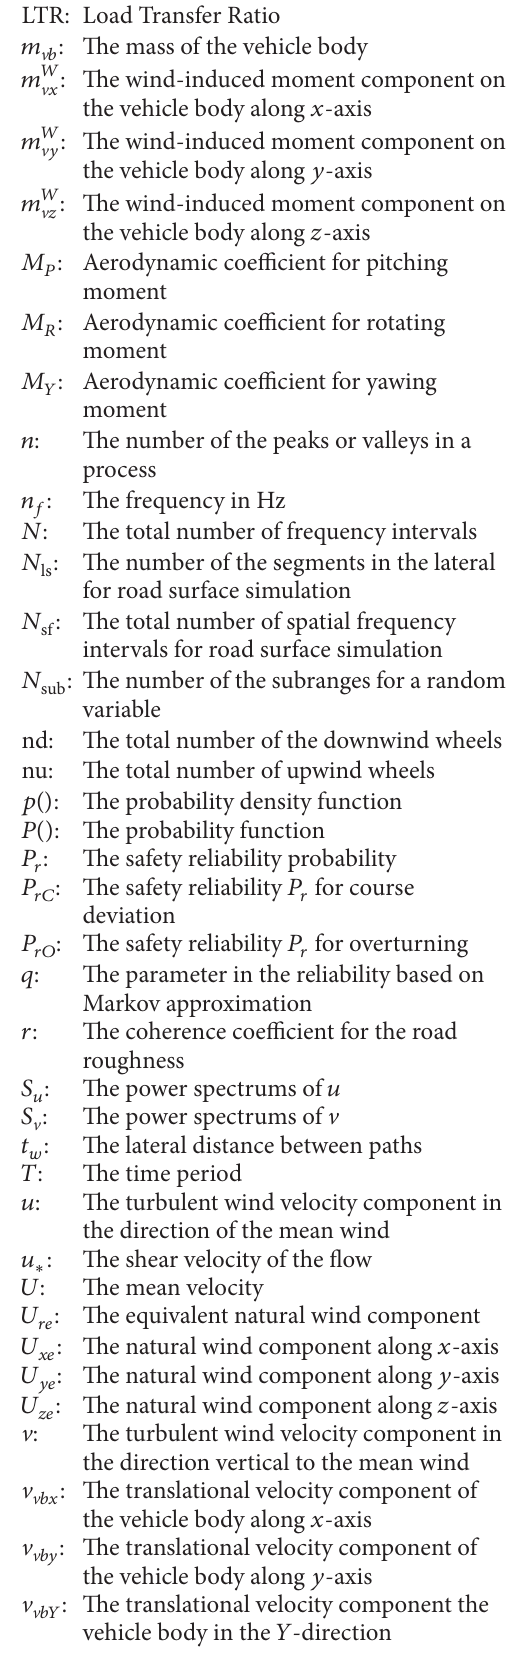
The aerodynamic coefficient for lift force 𝐶 The aerodynamic coefficient for side